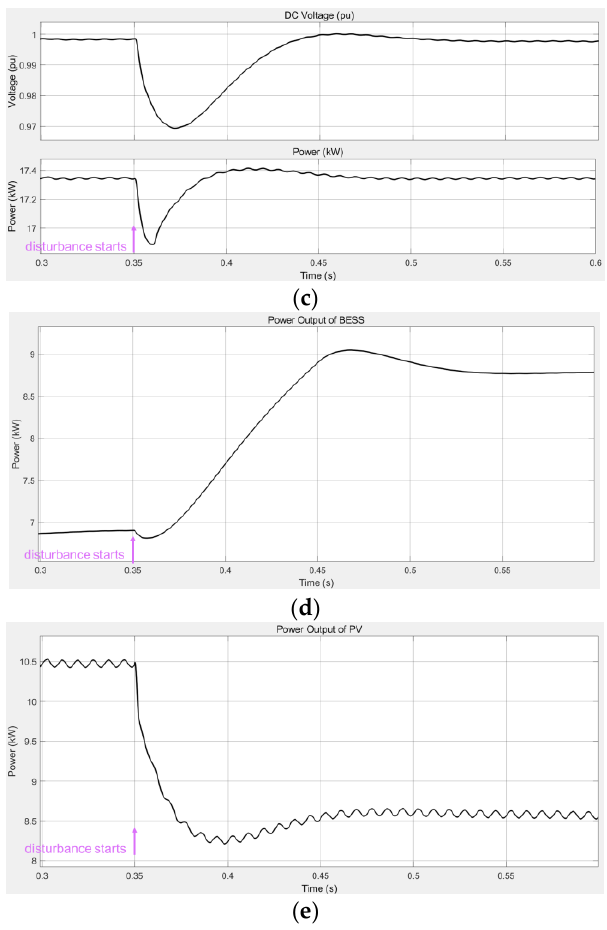
Figure 14. Performance when the PV operation environment changes. ( a ) Signals at Bus 6; ( b ) Signals at AC/DC interfacing Bus 8; ( c ) Signals at DC bus; ( d ) Power output of the BESS; ( e ) Power output of the PV generation.